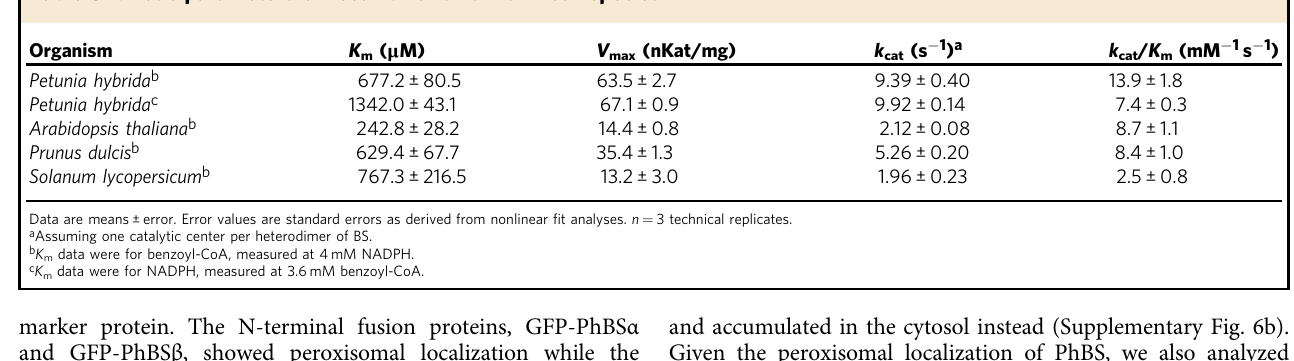
and accumulated in the cytosol instead (Supplementary Fig. 6b). Given the peroxisomal localization of PhBS, we also analyzed whether it could be involved in metabolism of short-chain fatty acyl-CoA esters. When puri fi ed PhBS was incubated with 1 mM